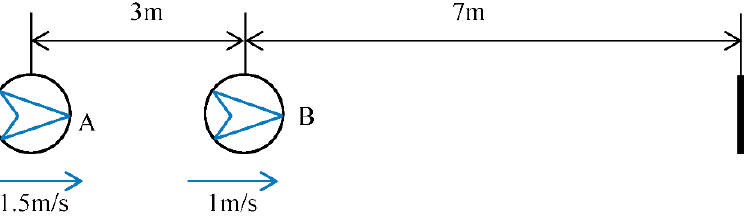
Figure 13. Scene of the following behavior.